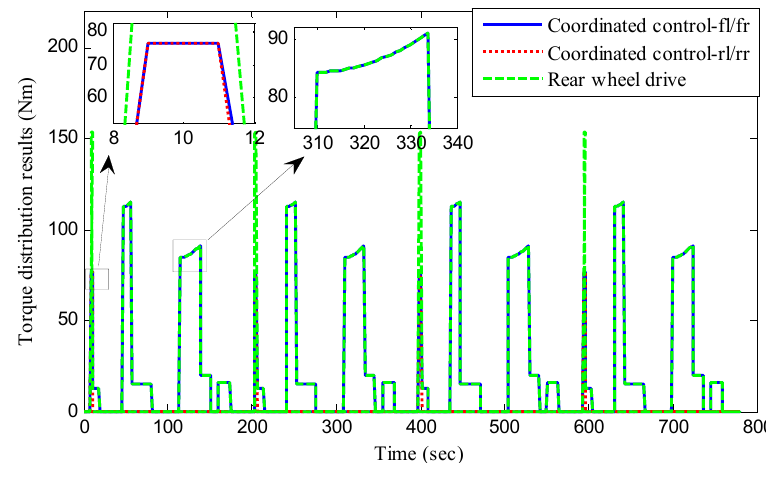
Figure 21. Torque distribution results in case study 3.